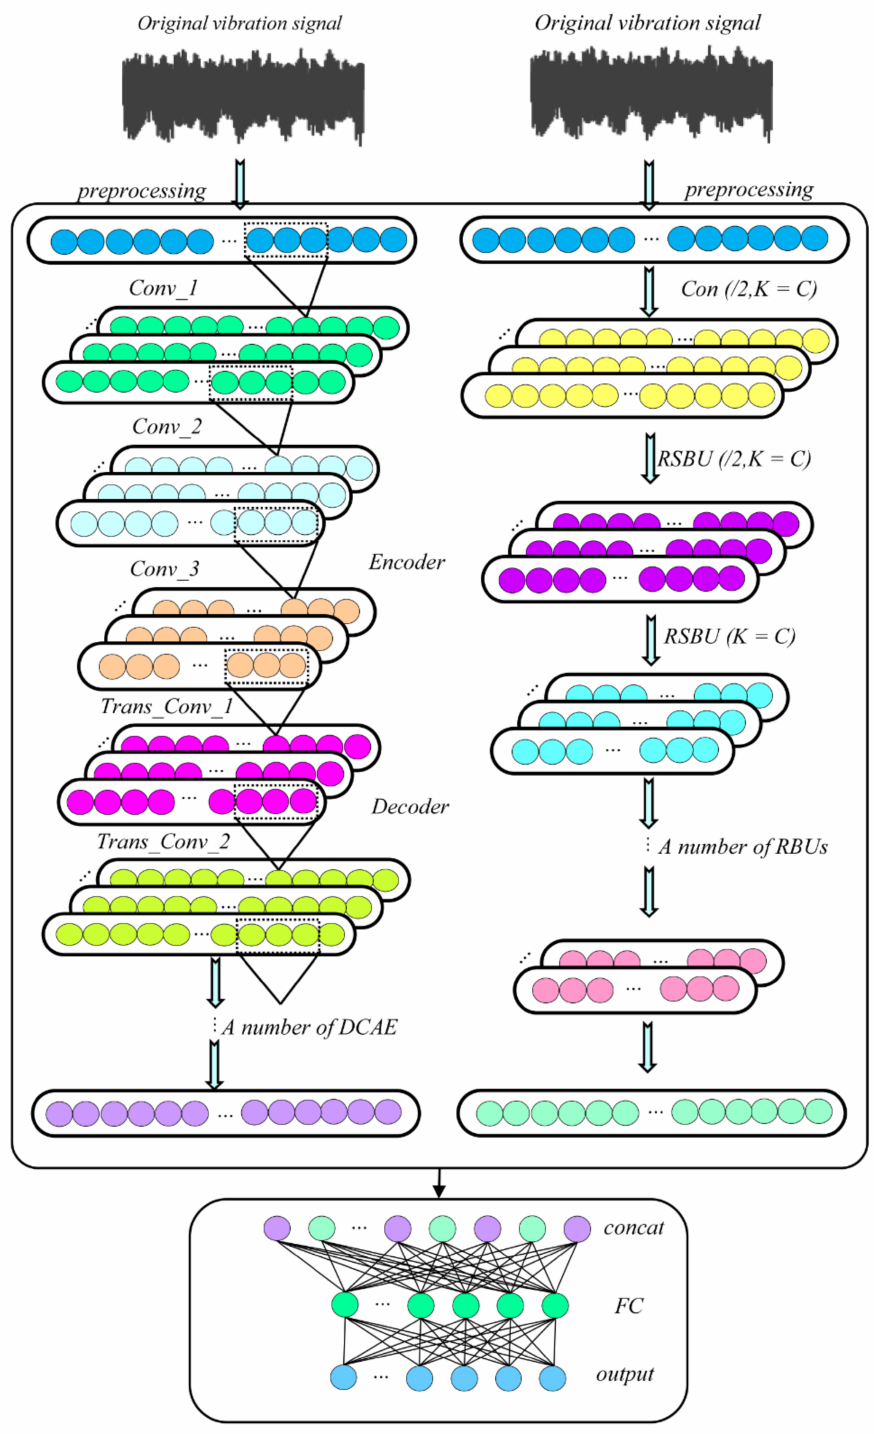
Figure 1. The fault diagnosis method based on a new adaptive feature extraction